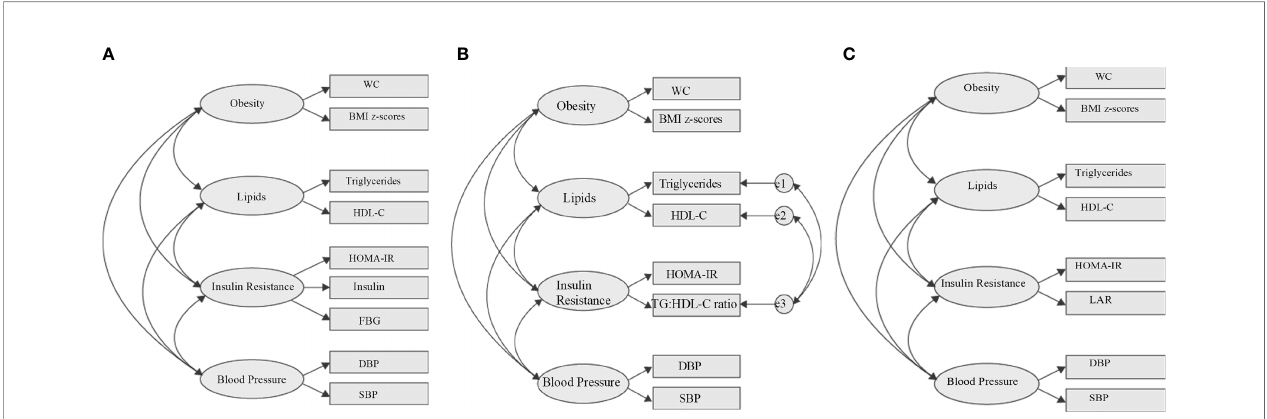
FIGURE 2 | Hypothesized metabolic syndrome factor structure. (A) Four-factor correlated model based on the IDF de fi nition. (B) Four-factor correlated model replacing fasting blood glucose with TG: HDL-C ratio to the IR component. (C) Referenced four-factor correlated model replacing fasting blood glucose with LAR to the IR component. WC, waist circumference; FBG, fasting blood glucose; DBP, diastolic blood pressure; SBP, systolic blood pressure; LAR, leptin:adiponectin ratio; e, residual covariance; HDL-C, high-density lipoproteincholesterol; HOMA-IR, homeostasis model assessment-estimated insulin